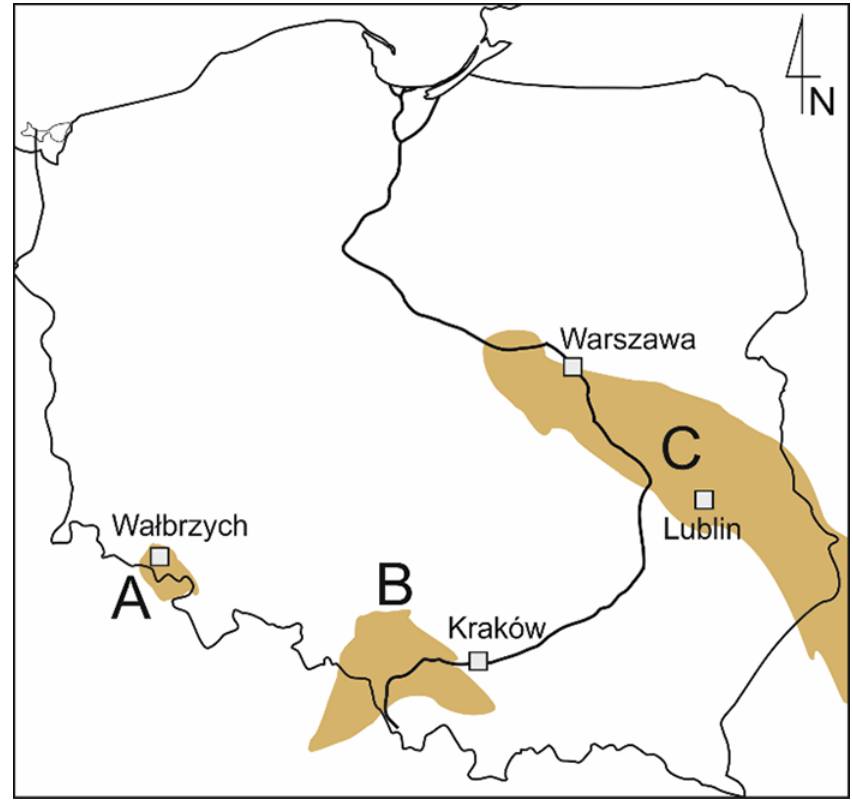
Figure 2 Polish Carboniferous coal basins and their span: ( A ) Lower Silesian Coal Basin; ( B ) Upper Silesian Coal Basin; ( C ) Lublin Coal